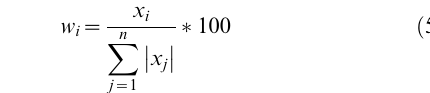
Food source Conversion